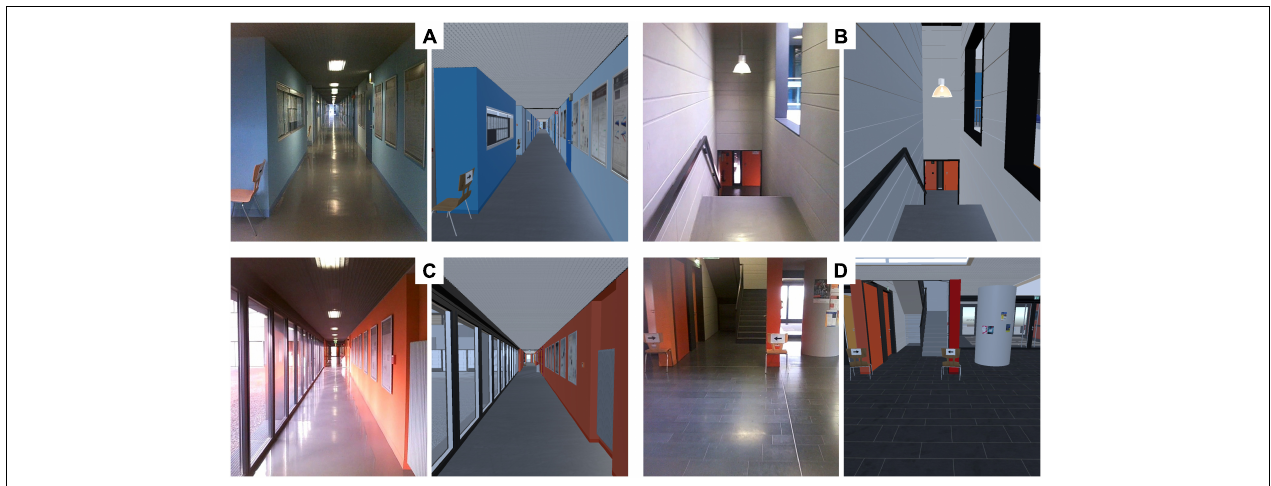
FIGURE 2 | Comparison of simulation and reality. Pairs of corresponding sample frames taken from the real world (left) and the virtual reality (right) recordings. VR rendering quality settings were as used during the experiment, (image quality can appear lower in the article pdf due to compression) RW were cut from the SMI glasses scene-camera recordings. (A) A corridor without windows. (B) Descending staircase. (C) A corridor with windows. (D) Parts of the lobby (not used in the analysis) and the entrance to an ascending